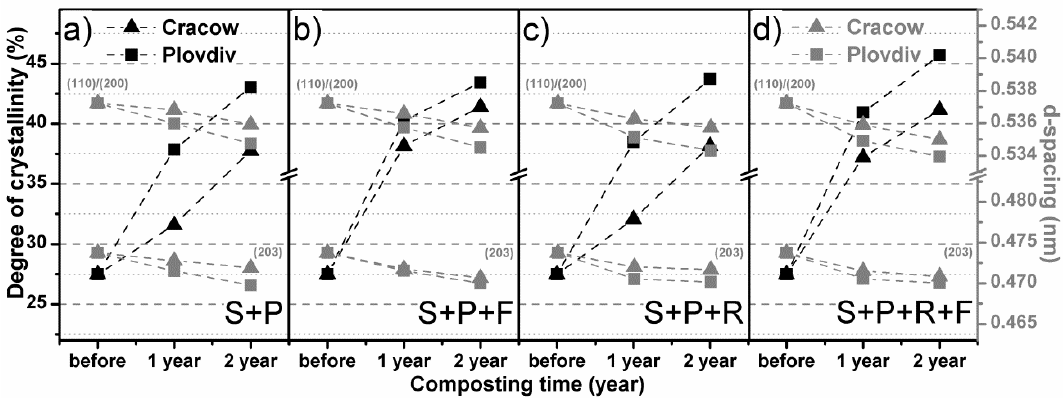
Figure 6. Numerical analysis results of WAXD diffractograms recorded for PLA spun-bonded mulching nonwovens before and after composting in: ( a ) soil with peat, ( b ) soil with peat covered with foil, ( c ) soil with peat and Radivit ® , ( d ) soil with peat and Radivit ® covered with foil.